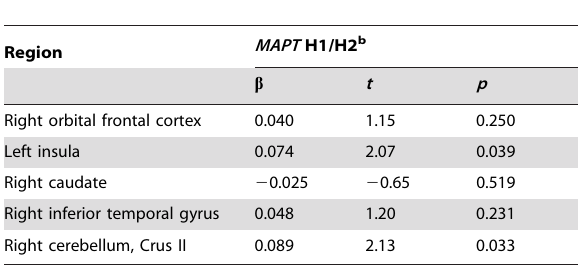
Table 3. Linear regression analyses to assess effect of MAPT diplotype on regional brain volumes a